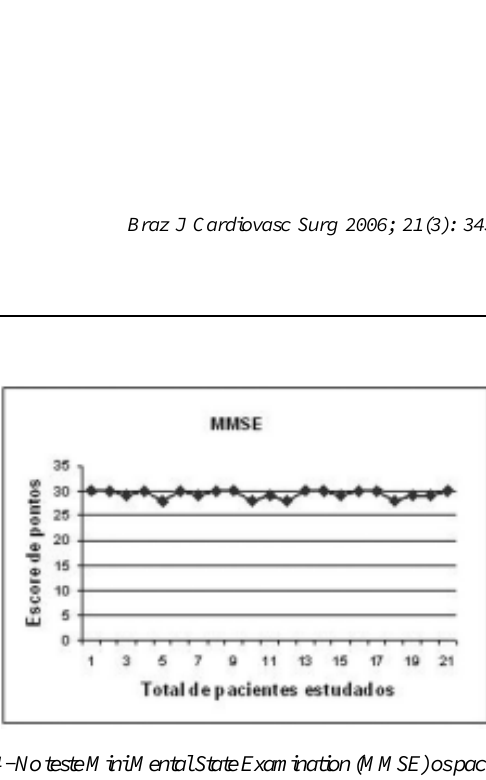
Fig. 4 - No teste Mini Mental State Examination (MMSE) os pacientes apresentaram escore igual ou próximo a trinta, não demonstrando alterações